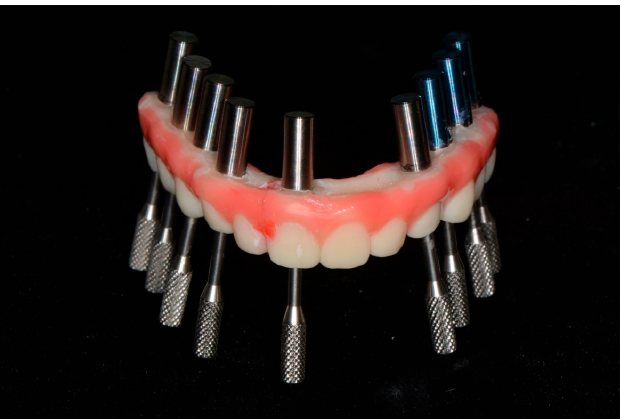
Figure 10. Laboratory tools that facilitate the bonding process to keep the cylinder access holes open.